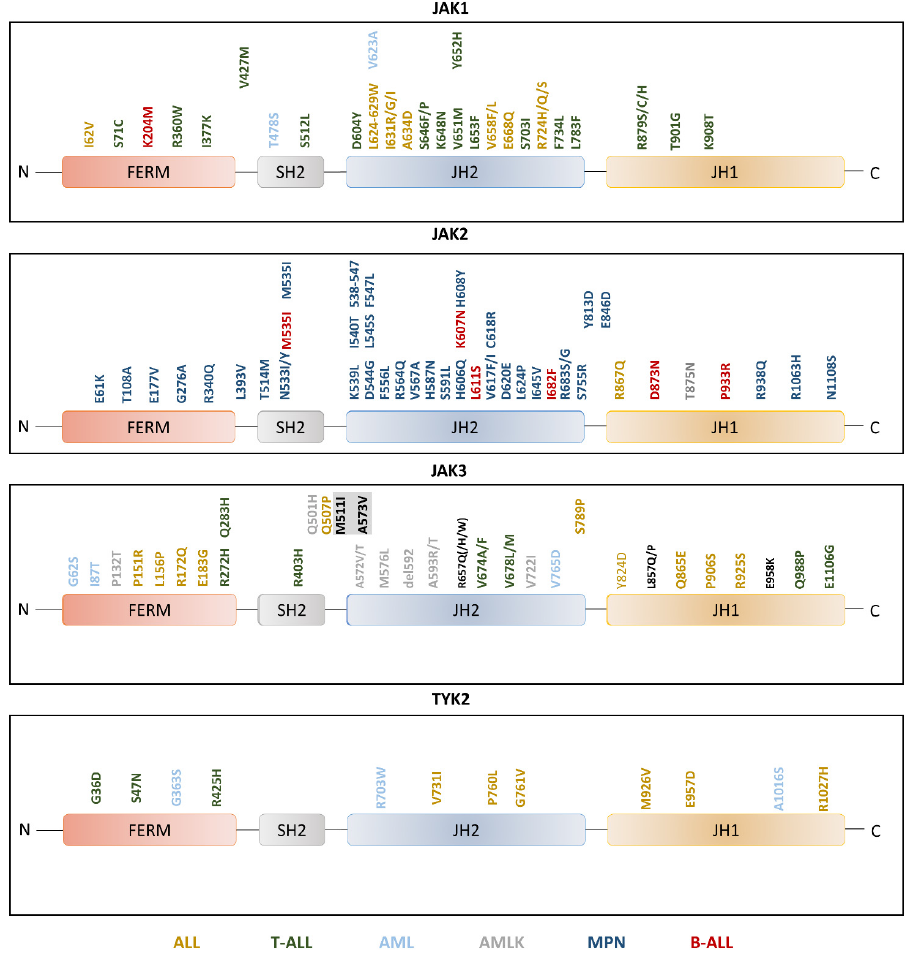
Figure 2. Leukemia-associated JAK mutations and their position in the domain structure. The mutations are colored based on the type of leukemia (acute lymphocytic leukemia (ALL): yellow, T-ALL: green, acute myeloid leukemia (AML): light blue, AMLK: grey, myeloproliferative neoplasms (MPN): blue, B-ALL: red). The figure is based on the table from Hammarén et al. [2]. Altered function of the cytokine receptors or STATs may lead to similar effects as seen with mutated JAKs. Mutations in STAT3 and (to a lesser extent) STAT5 have been evaluated to be frequently leukemogenic in adults with large granular lymphocyte leuke- mia, and activating somatic STAT3 mutations have been found in T and B cell lymphomas and chronic lymphoproliferative disorders of NK cells [96,97]. STAT5 has a key role in the induction of BCR-ABL-driven ALL and CML [98,99]. Furthermore, mutations in STAT5 are recurrent in T-ALL, and together with the observed mutations in the IL7R and JAK1